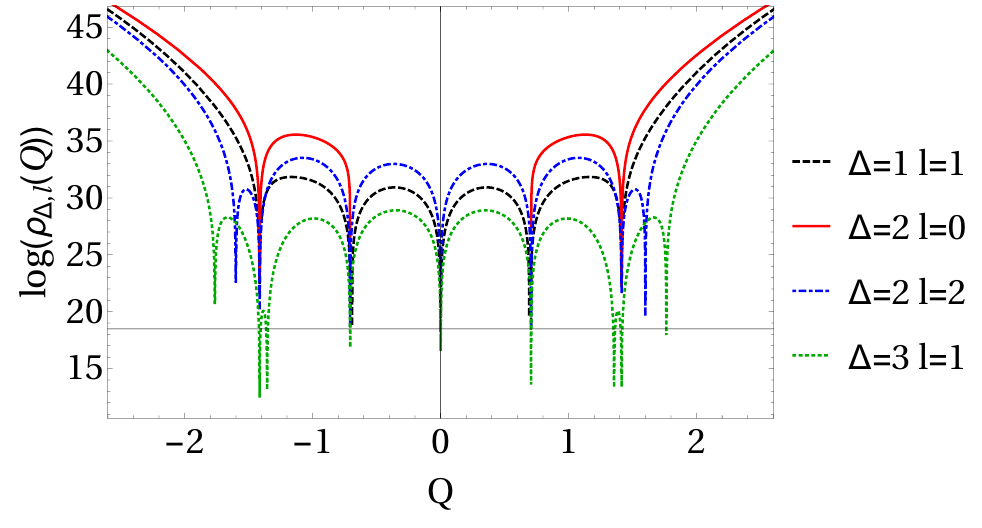
Figure 10 . Extremal functional of Q at n D = 19 when the gap on Q is maximized at 1 p